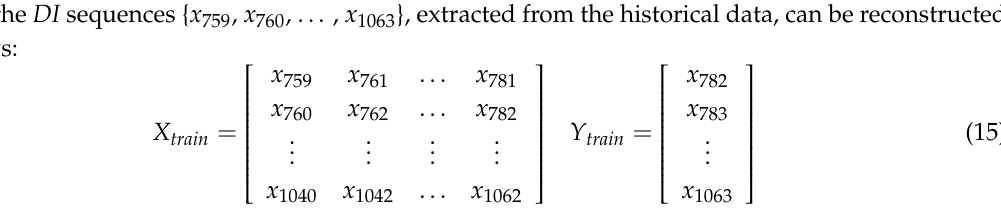
Table 2. Parameter settings of PSO method. Parameter The Value The maximum number of generations 200 The number of the particles 20 Learn factors 1.5,1.7 Inertia weight 1 The initial range of C [0,1000] The initial range of σ [0,100] The initial range of ε